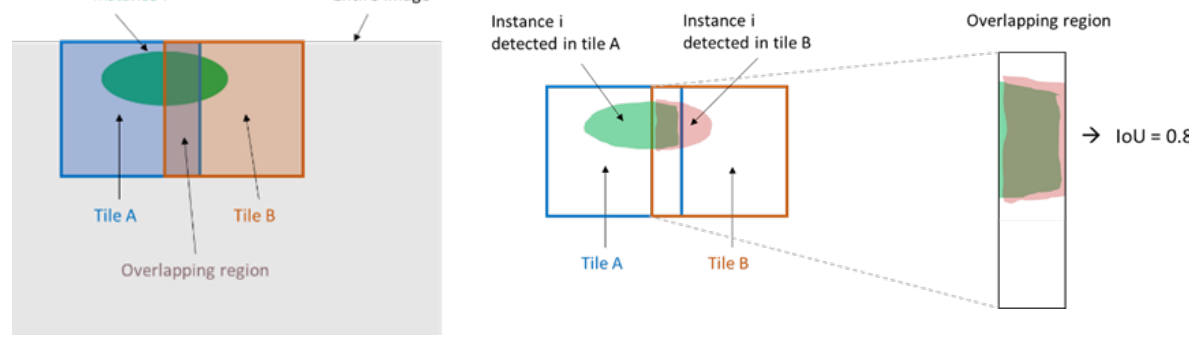
Figure 13. Merging of instances between adjacent sliding widow positions.